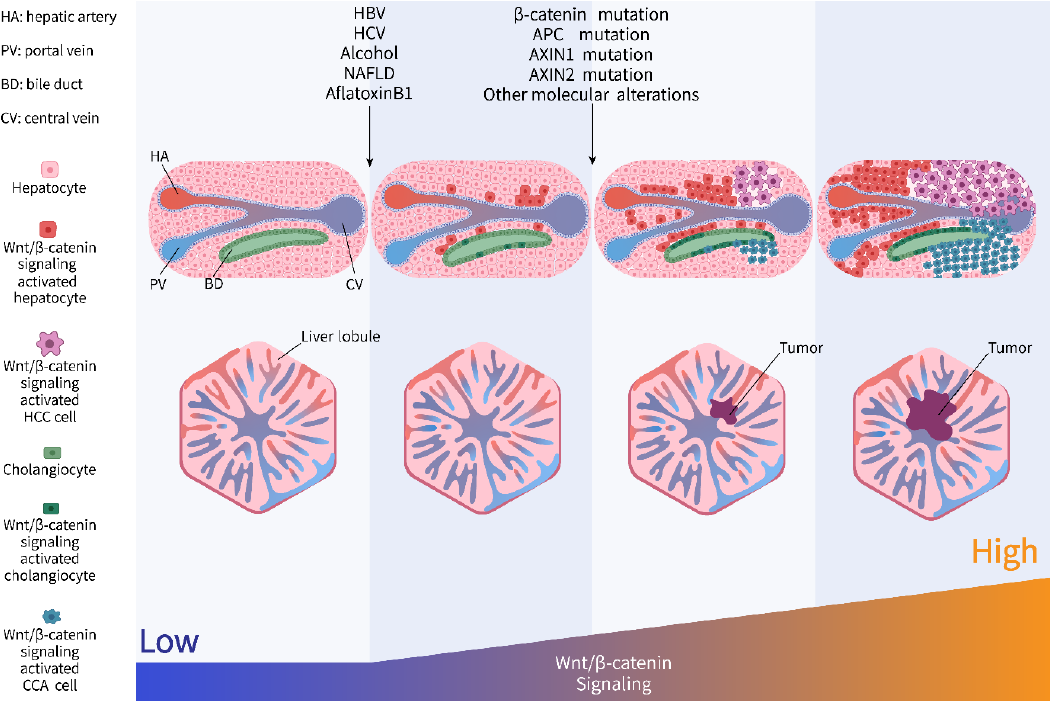
Figure 2. Dynamic activation of Wnt/β -catenin signaling from risk factor exposure to final liver cancer.